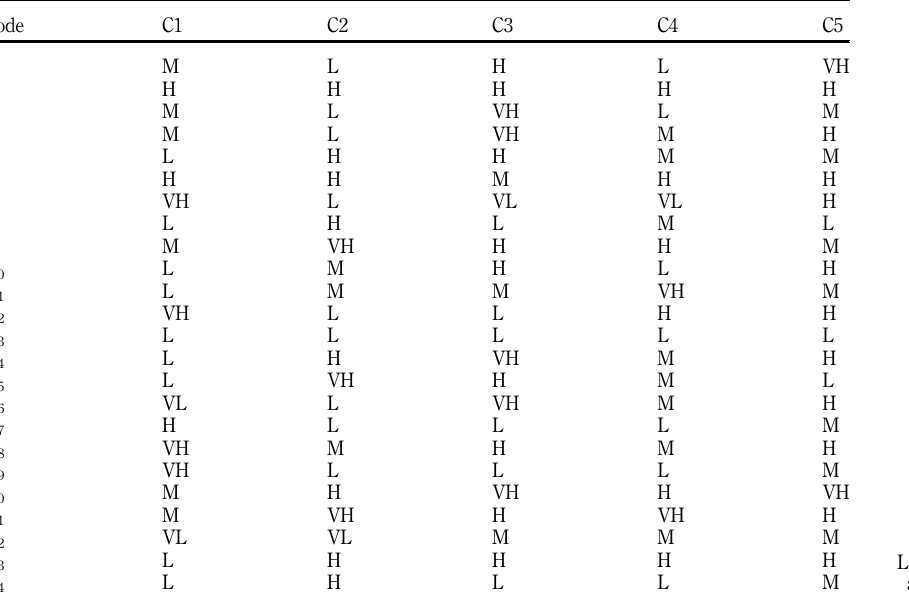
Table A4. Linguistic variable